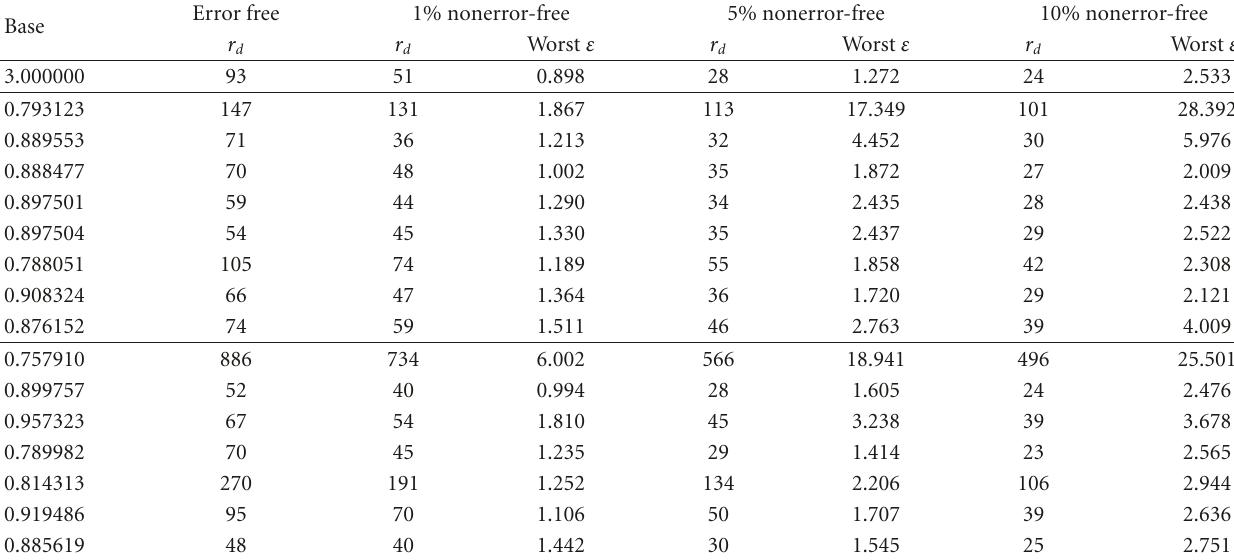
Table 3: Data representation performance for various